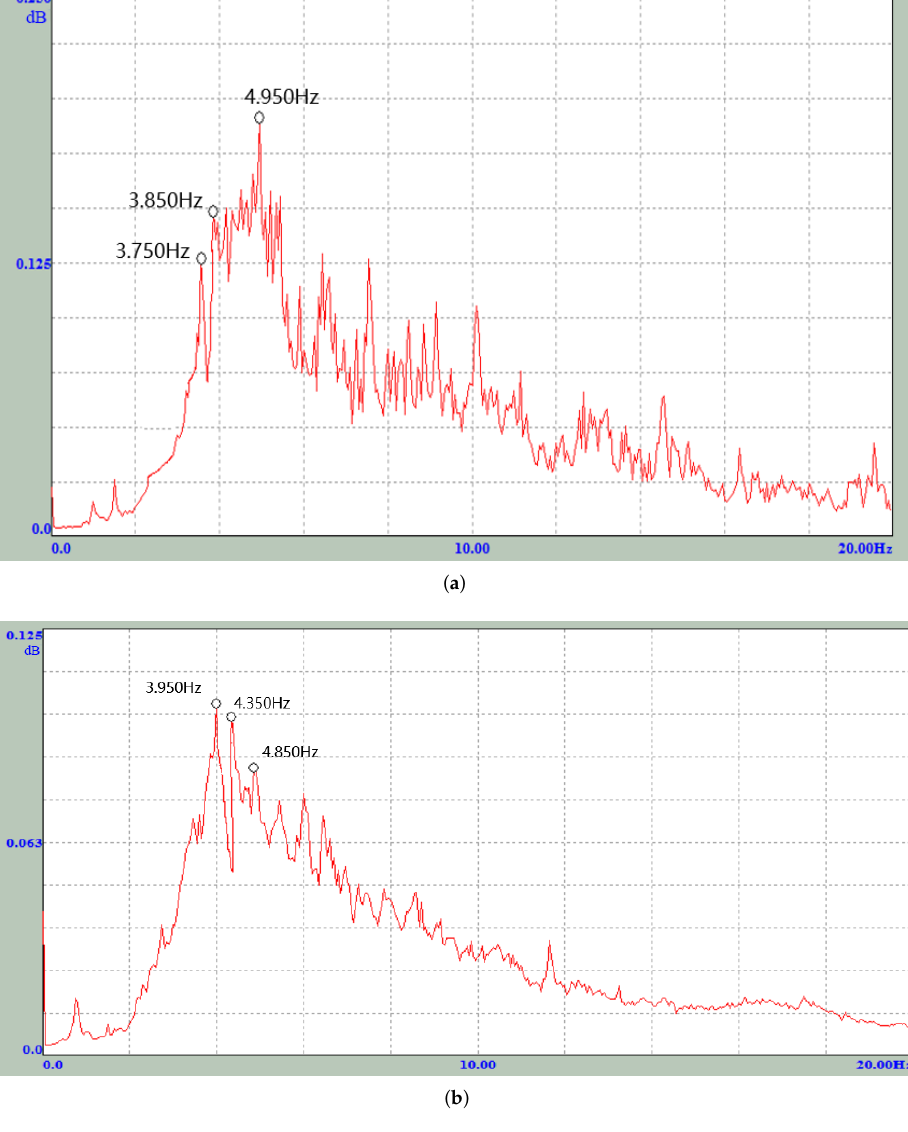
Figure 5. Self-power spectrum of each modal measurement area. ( a ) Area 1; ( b ) Area 2. Taking the average value as the damping of the structure, Table 2 shows that structural damping is